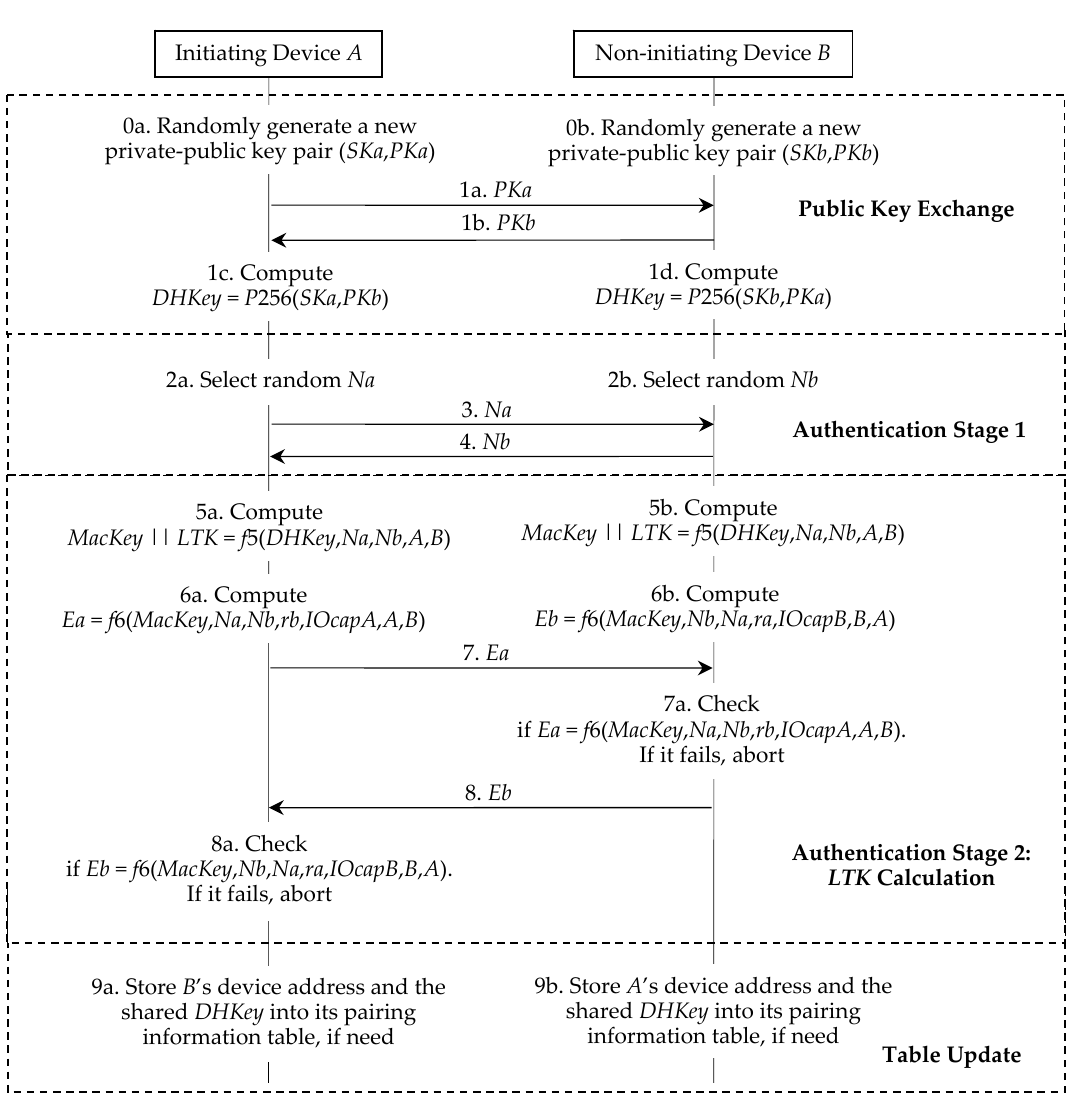
Figure 10. Modified LESSP protocol Π ’.